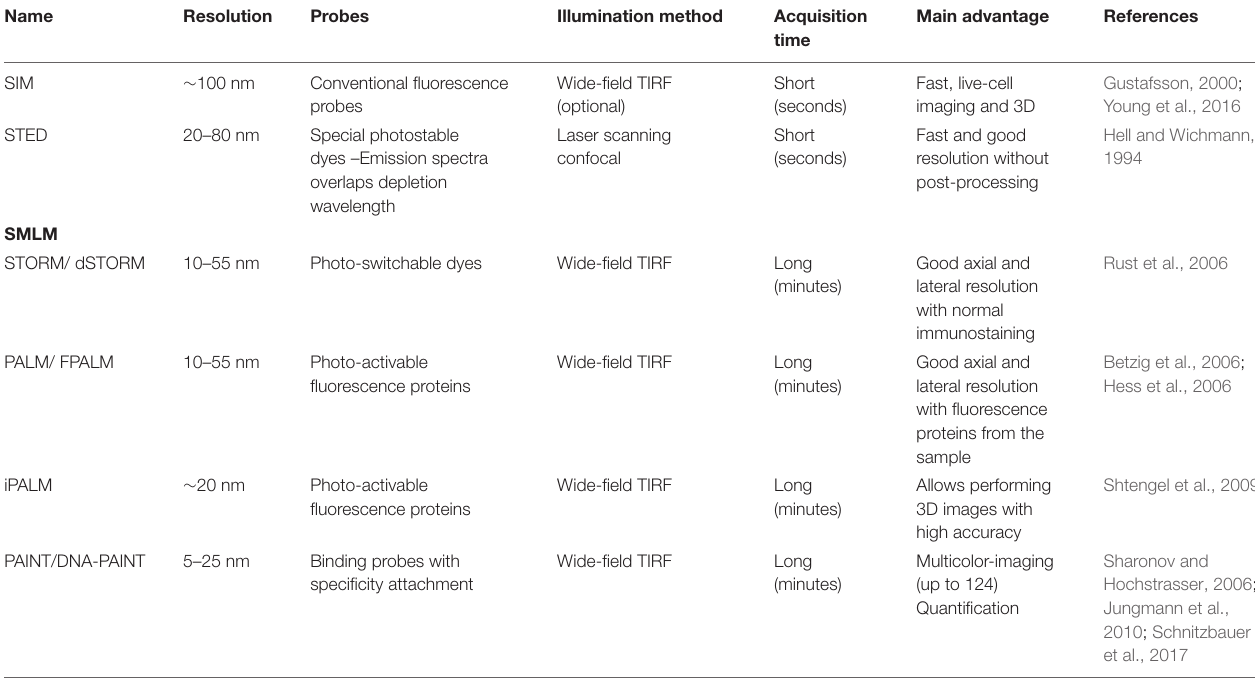
TABLE 1 | Resume of the main super-resolution microscopy techniques. STORM, PAINT, PALM, and their derivate can be classified as single-molecule localization microscopy